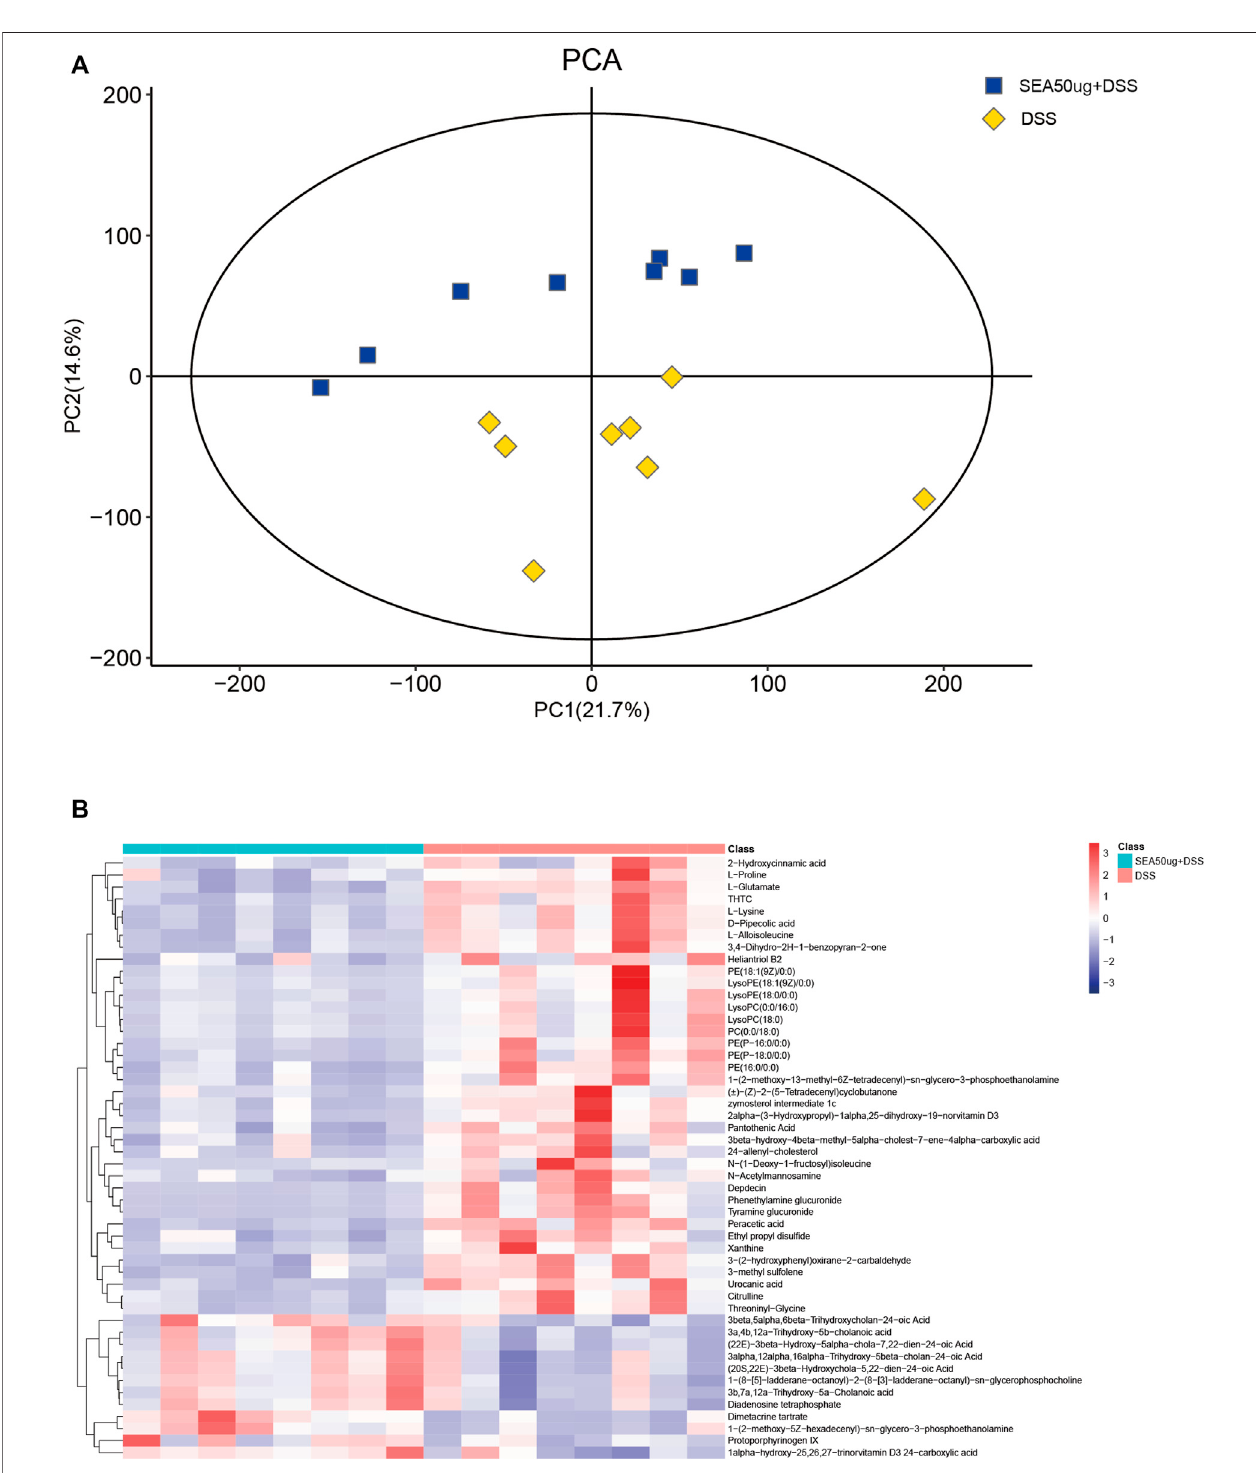
FIGURE4| SEAalteredthecontentsofDSS-inducedintestinalmetabolitesinmicewithIBD. (A) 2Dprincipalcomponentanalysis(PCA)ofthecontentsofintestinal metabolitesintheDSSandSEA50 μ g+DSSgroups.YellowrepresentstheDSSgroup,andbluerepresentstheSEA50 μ g+DSSgroup.Each iconrepresents asetof samples. (B) Heatmapsofthetop50differentialmetabolitesofintestinalcontentsintheDSSandSEA50 μ g+DSSgroups.TheleftbluebarrepresentstheDSSgroup, and the right side represents the SEA 50 μ g + DSS group. Each small squarein the fi gure corresponds toa mass error. The red square represents apositive mass error, while the blue square represents a negative mass error. The darker the color, the greater the value.